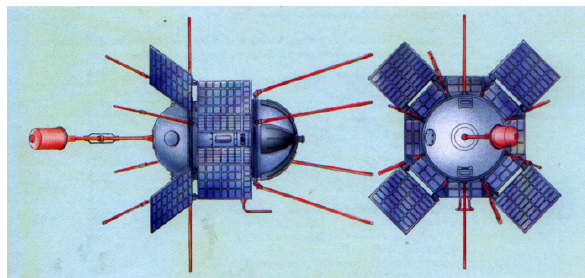
Figure 2. External view of the DS-U2-MG spacecraft (Kosmos-321 and Kosmos-356), 1970 (Konyukhov,